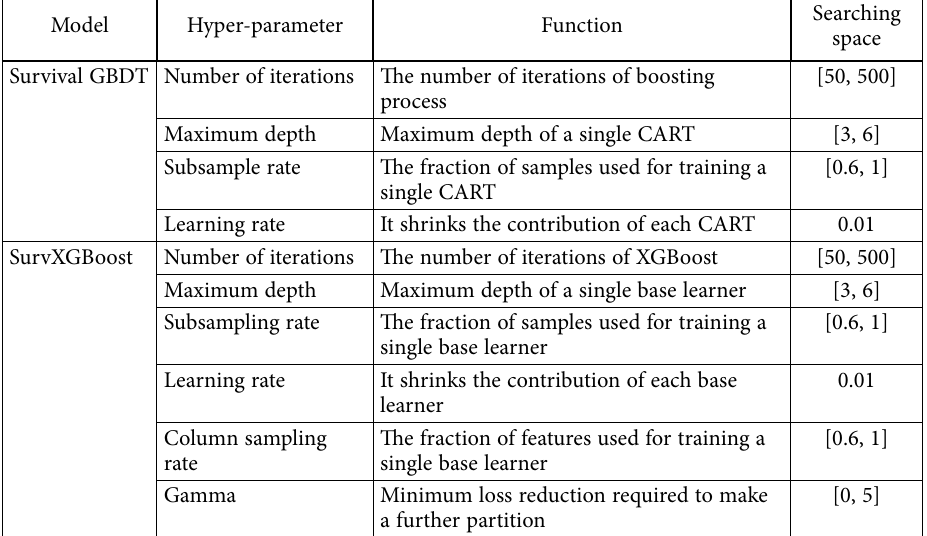
Searching space [50,